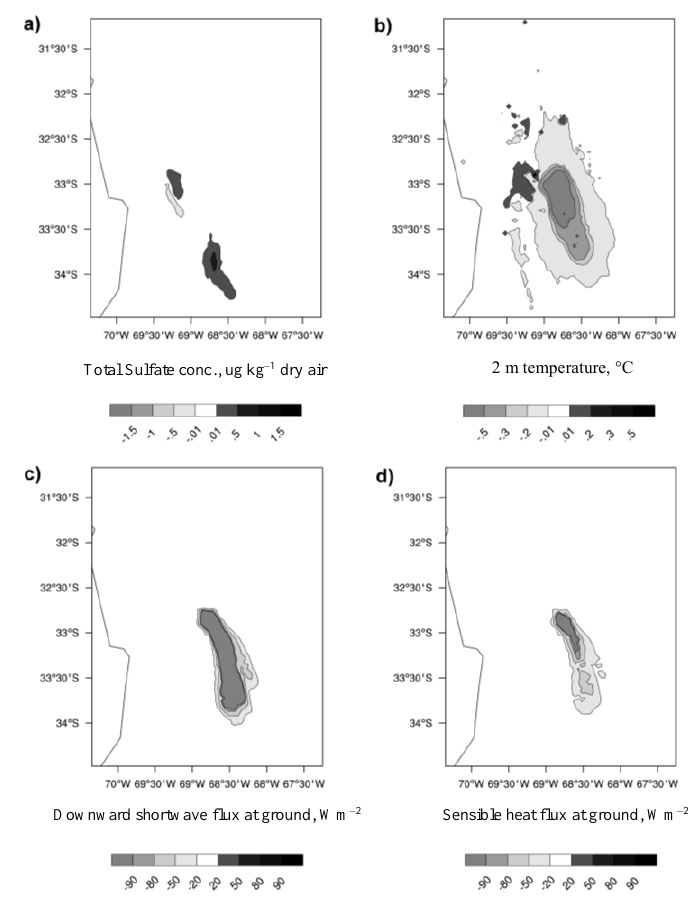
Fig. 13. Anomaly calculated as ID5 − Test_Control on January 8, 2012 at 12:00 LT for: a) total (Aitken mode + Accumulation mode) SO 42 − concentration at surface; b) surface temperature; c) surface incident shortwave radiation; d) surface sensitive heat